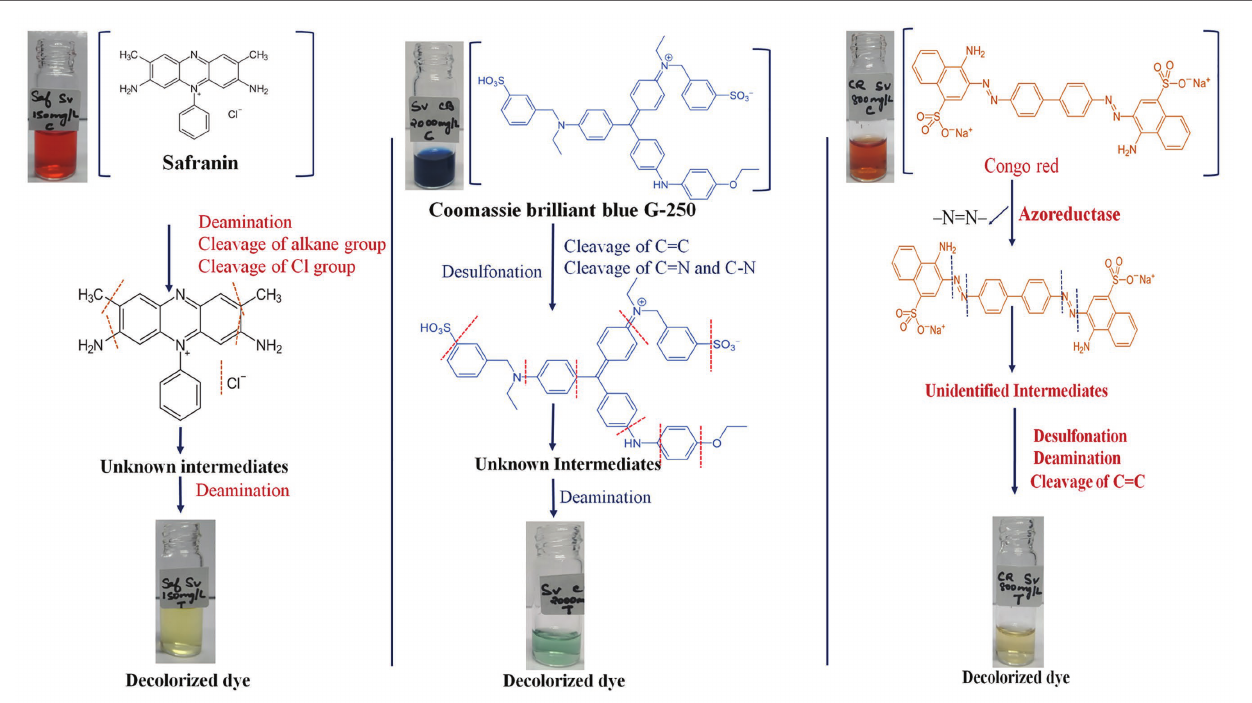
FIGURE 2 | Predicted mechanism of dye decolorization by Salinivibrio kushneri HTSP based on Fourier Transform Infrared (FTIR) peaks and functions of the genes identified. Functional group and bond cleavages are identified through the FTIR